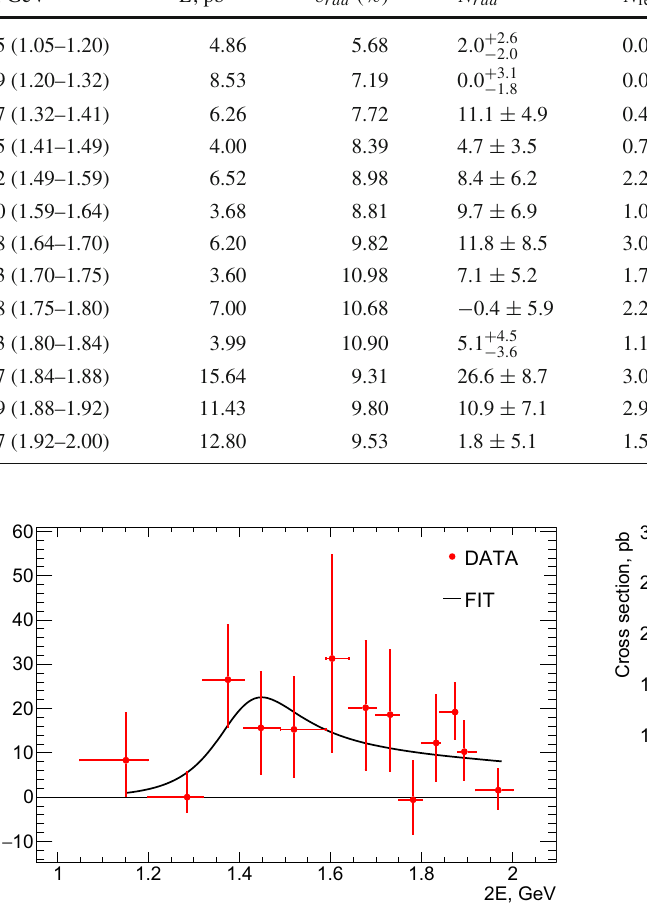
Fig. 6 Themeasuredtotalcrosssectionfortheprocess e + e − → ηπ 0 γ (circle) and the cross section for the process e + e − → ωη → ηπ 0 γ (squares). The curve is the result of the fit described in the text